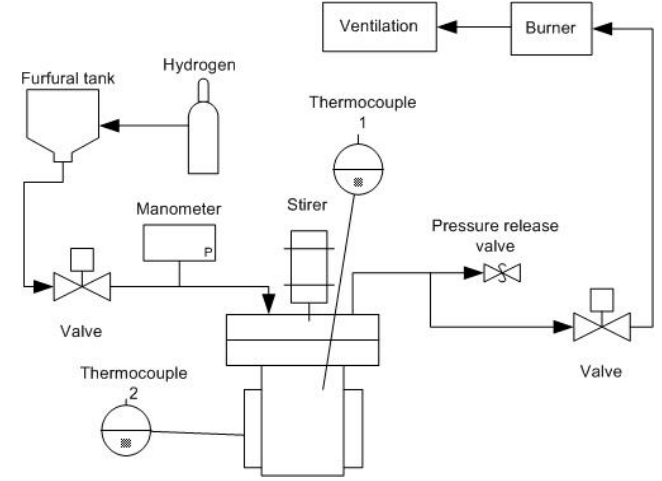
Figure 5. Process and instrumentation diagram for the liquid-phase hydrogenation of furfural.